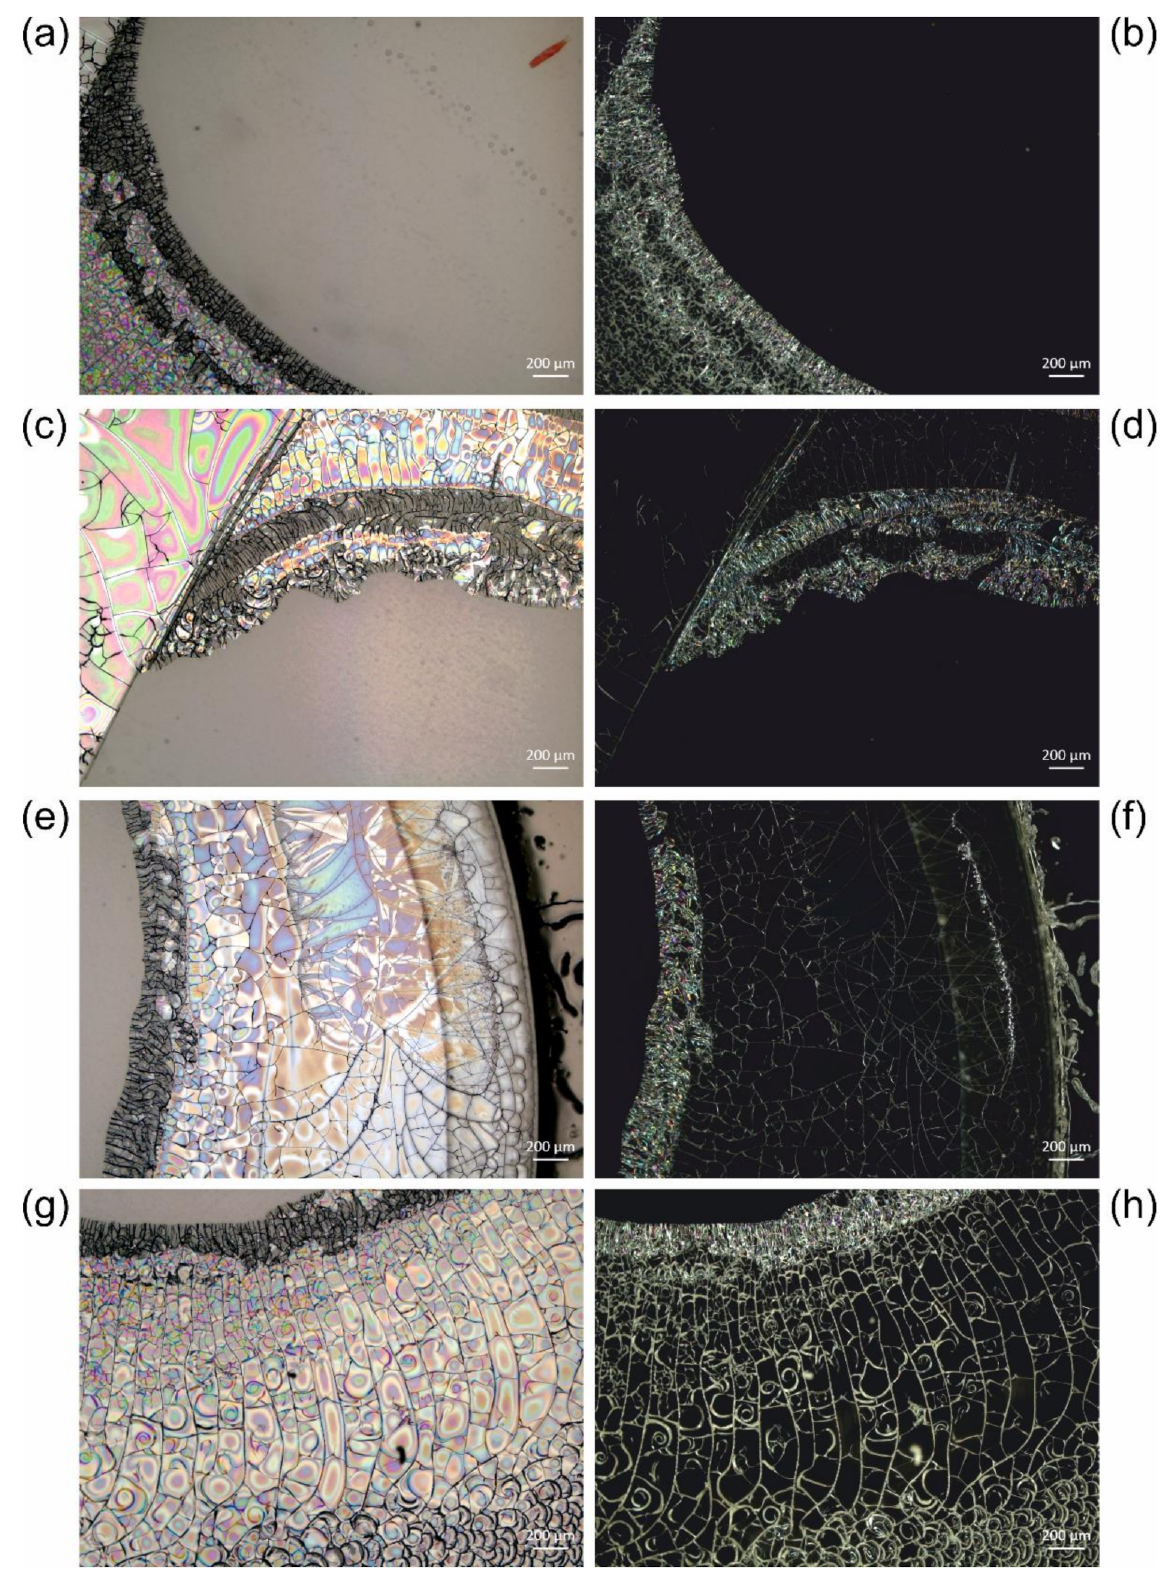
Figure 5. Different examples of crack formation in Permount TM , sample USNM 1226533, Cateria gerlachi : ( a , c , e , g ) reflected light brightfield and ( b , d , f , h ) reflected light darkfield